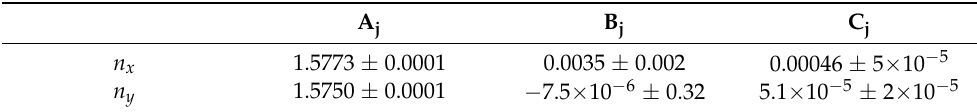
Table 1. Cauchy parameters for n x and n y in Equation (4).